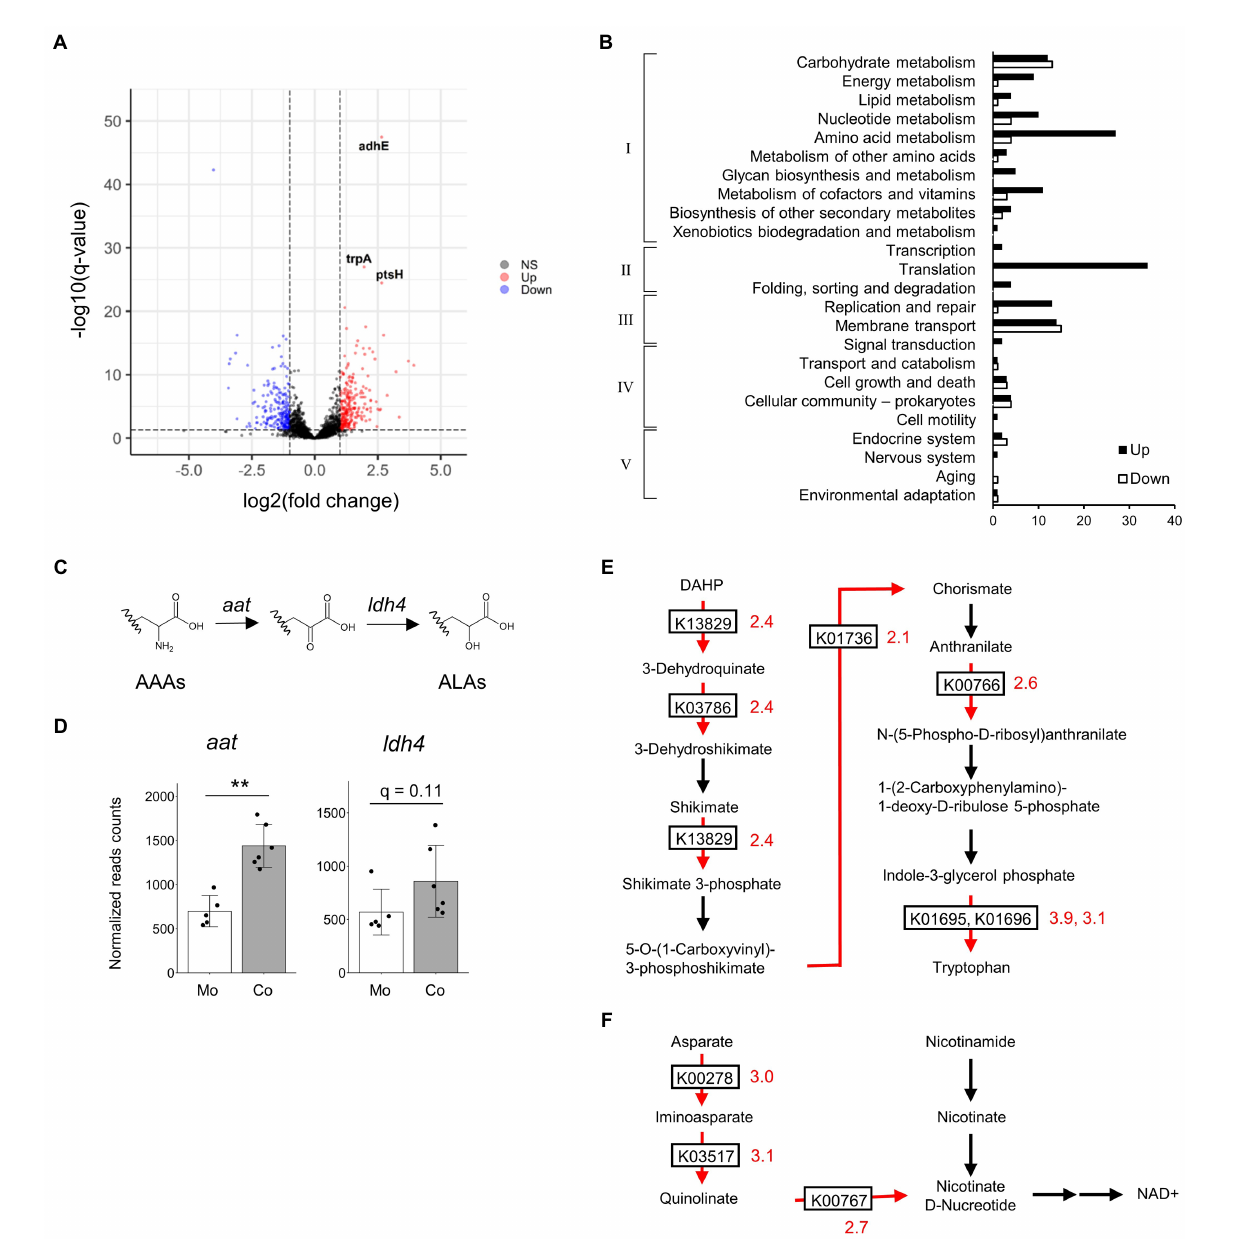
FIGURE 4 Comparison of gene expression profiles of B. breve MCC1274 in monoculture and in co-culture with IECs. (A) Volcano plot of total gene expression. Vertical and horizontal dotted lines indicate the fold-change value |FC| = 2 and a q -value of 0.05, respectively. Upregulated DEGs in the co-culture conditions are labeled in red, while downregulated DEGs are labeled in blue. RNA-seq was performed on five to six samples from two independent experiments. (B) KEGG Orthology (KO) functional classification of annotated DEGs. The horizontal axis represents the number of genes. Categories I–V represent the following mapped KEGG pathway categories: I, Metabolism; II, Genetic Information Processing; III, Environmental Information Processing; IV, Cellular Processes; V, Organismal Systems. (C) Aromatic amino acid synthesis pathway. (D) The normalized read counts from RNA-seq analysis. Mo, B. breve MCC1274 monocultured in the tube; Co, B. breve MCC1274 co-cultured with IECs. ** q < 0.01 (Deseq2). (E,F) Tryptophan synthesis pathway components: (E) NADH synthesis (F) The red arrow indicates the enzymes whose gene expression was upregulated in co-culture (fold change >2, q -value <0.05). Black arrows indicate gene expression that was not significantly changed. The numbers next to the boxes describing KEGG Orthology indicate fold change. AAAs, aromatic amino acids; ALAs, aromatic lactic acids; APAs, aromatic pyruvic acids; DHAP, 2-Dehydro-3-deoxy-D- arabino-heptonate